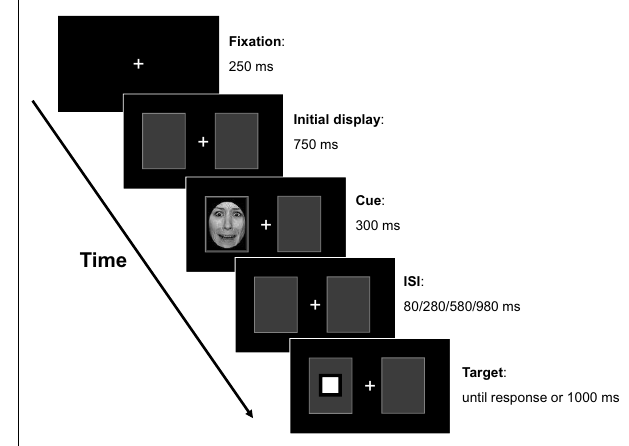
FIGURE 1 | Schematic of procedure used in the spatial cueing task . Each trial had the following sequence: fixation, initial display, cue, inter stimulus interval (ISI), target, and response.The picture shows an example of a cued trial with a threatening face target (not drawn exactly to scale).